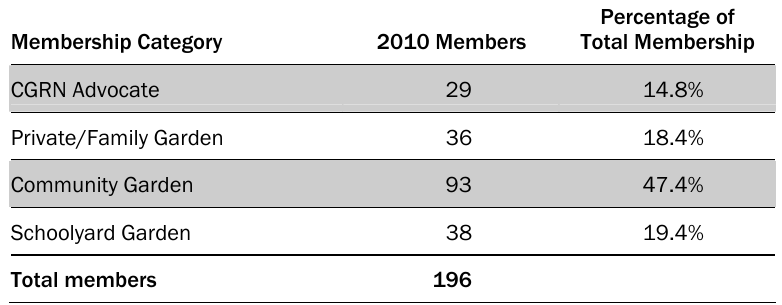
Figure 3. 2010 CGRN Members by Membership